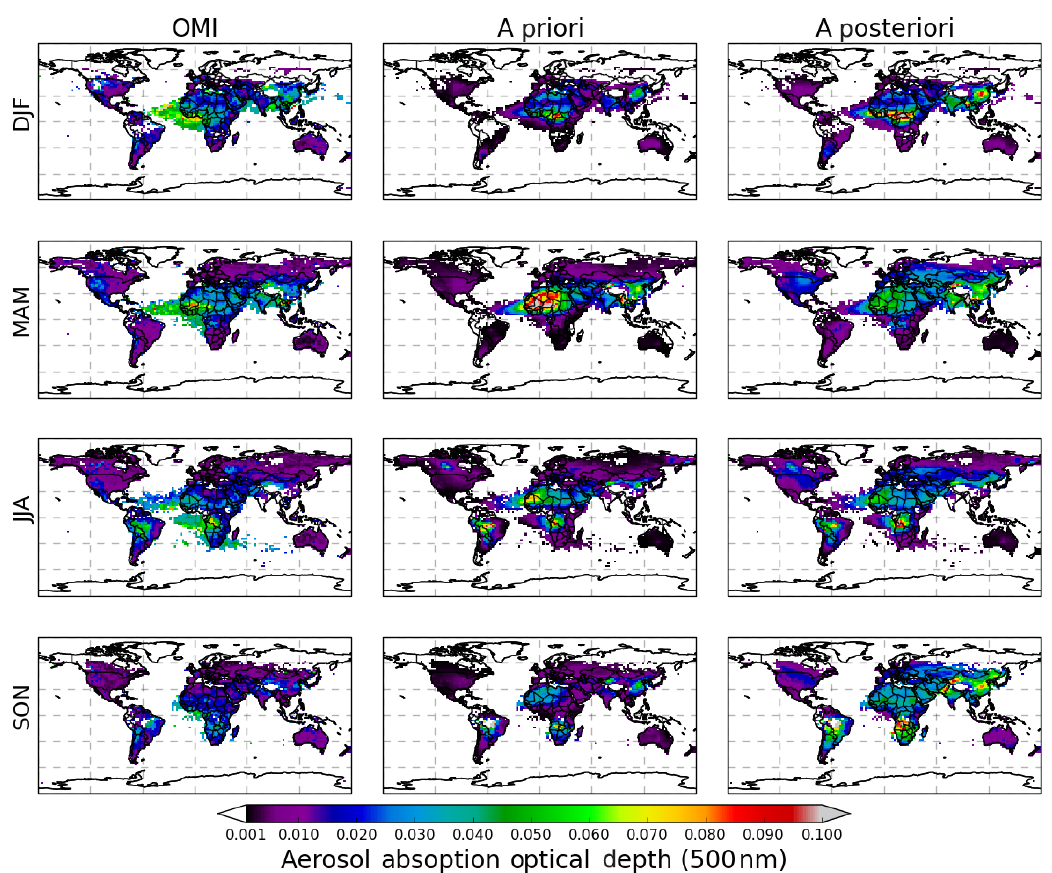
Figure 11. Comparison of a priori and a posteriori GEOS-Chem simulated seasonal AAOD at 500nm with OMI/OMAERUV products.